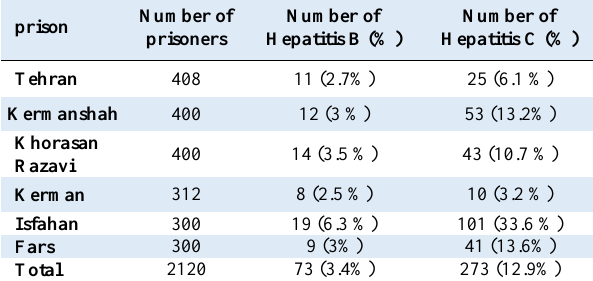
Table 1. The prevalence of Hepatitis B and C in various prisons in Iran